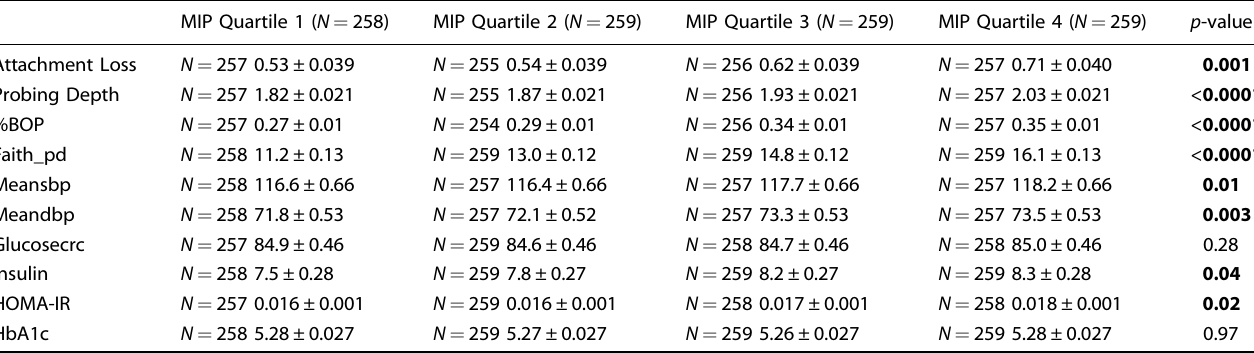
Table 5. Quartiles of Microbial Indicator of Periodontal Disease (MIP) in subgingival plaque and multiple measures of periodontal disease and markers of cardiometabolic health.